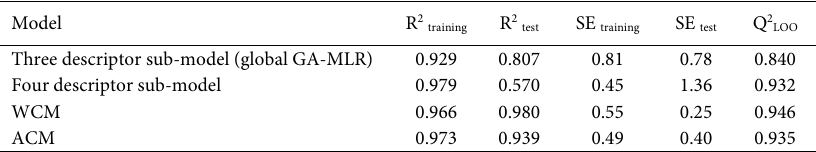
Table 3. Statistical parameters and validation of sub-models, WCM, and ACM.